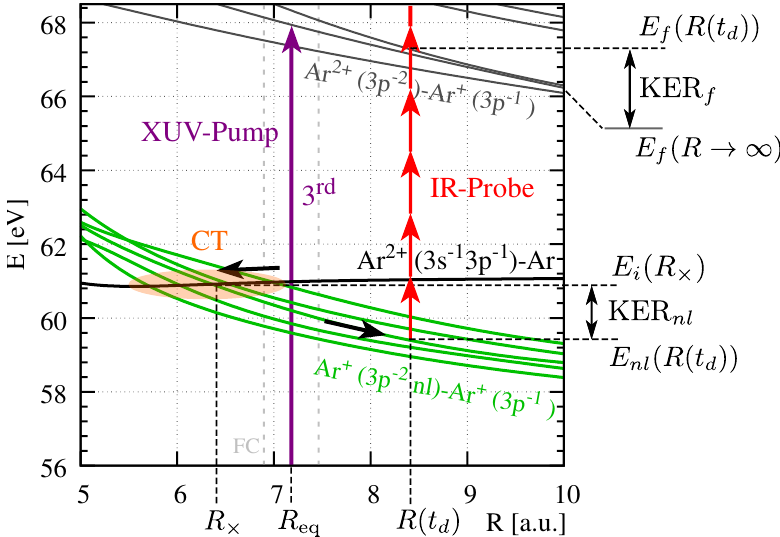
Figure 5. Potential energy curves of the argon dimer in the energy range 56eV–68.5eV . The XUV pump (purple arrow) populates the initial Ar 2 + ( 3s − 1 3p − 1 ) − Ar state (black curve) at R eq . The wave packet starts to evolve to smaller R . At the crossings (orange-shaded area) with Ar + ( 3p − 2 nl ) − Ar + ( 3p − 1 ) states (light-green curves), charge transfer (CT) happens. The IR probe (red arrows) interrogates the population of the Ar + ( 3p − 2 nl ) − Ar + ( 3p − 1 ) states by ionization to final Ar 2 + ( 3p − 2 ) − Ar + ( 3p − 1 ) states (dark-grey curves). Specific potential energies and corresponding internuclear distances are indicated by horizontal and vertical dashed lines, respectively. Reproduced from [5], with the permission of AIP (American Institute of Physics) Publishing.